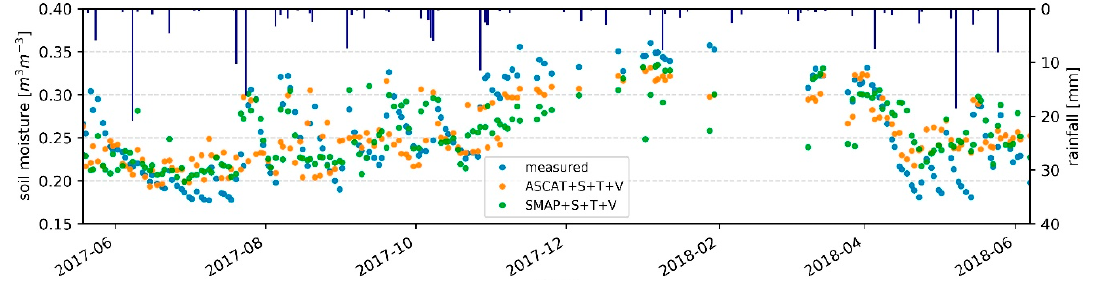
Figure 8. Temporal patterns of catchment scale soil moisture. The predicted soil moisture (model combination SSM + S + T + V) was spatially averaged and compared to the average of in-situ measurements over the catchment (blue dots).